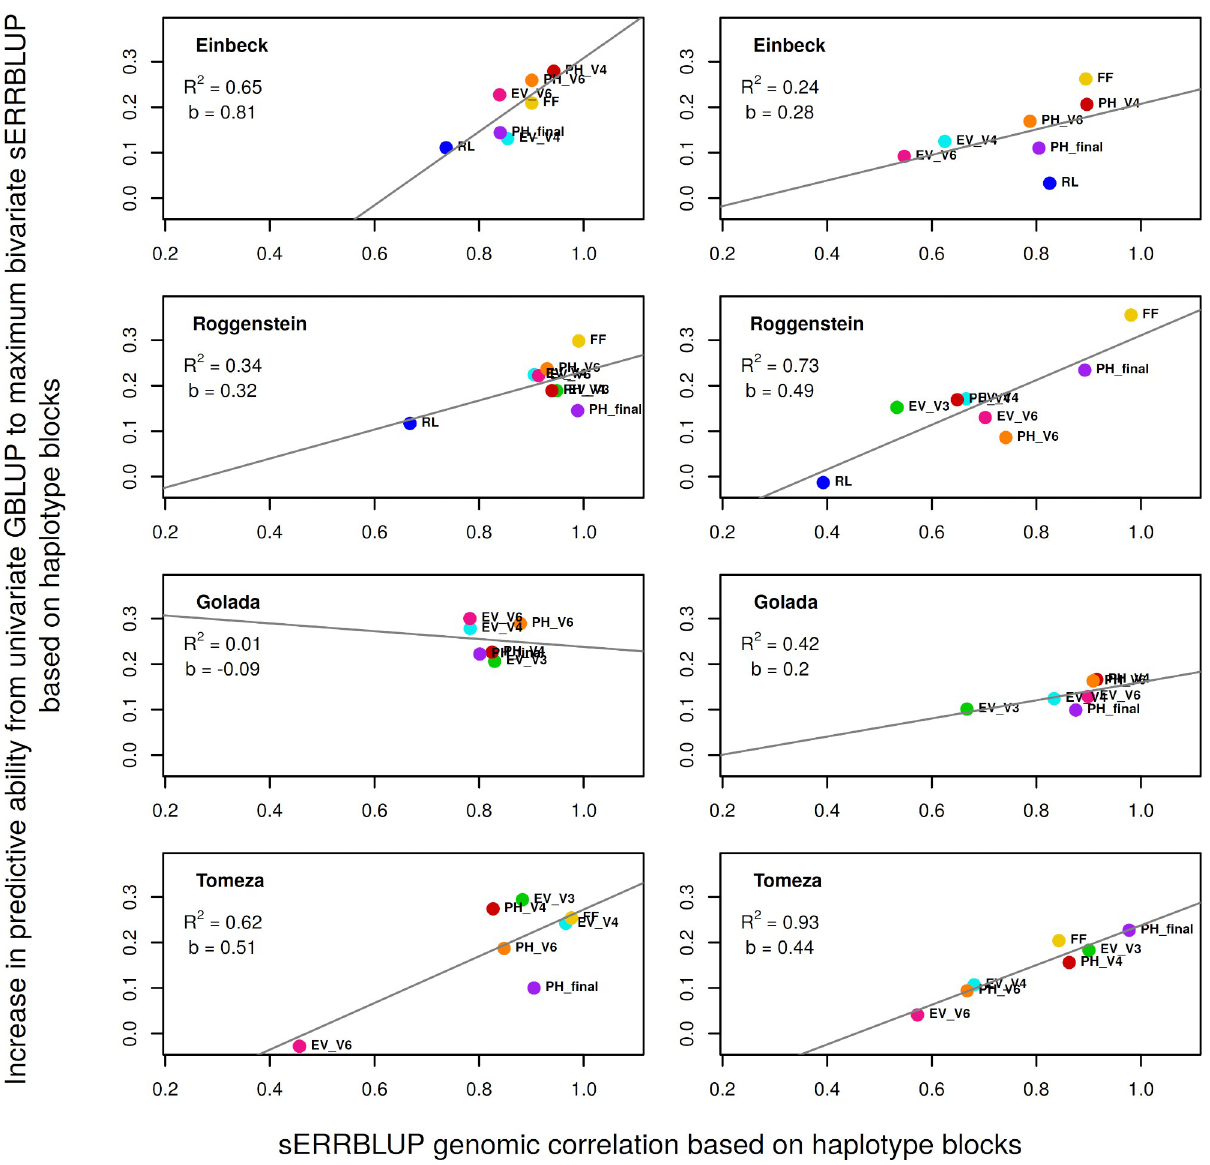
Fig 3. Regression of the absolute increase in predictive ability from univariate GBLUP to maximum bivariate sERRBLUP on the respective sERRBLUP genomic correlation between 2017 and 2018 in Kemater (left) and in Petkuser (right) for all studied traits. In each panel, the overall linear regression line (gray solid line) with the regression coefficient ( b ) and R-squared ( R 2 ) are